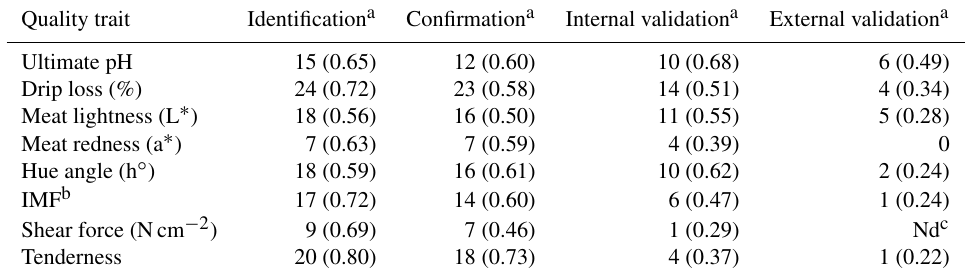
Figure 1. Identification of biomarkers of meat quality by transcriptomic analysis of longissimus muscle: association between gene expression level on muscle 15K microarray and individual meat quality traits (ultimate pH; colour: lightness, redness, hue angle; drip loss; intramuscular fat content; shear force of cooked meat; sensory tenderness; and juiciness). Table 2. Identification, confirmation and validation of biomarkers of pork quality. Significant correlations ( P <0.05) between meat quality traits and the expression level of 40 genes at steps of identification (microarray, n = 50 pigs), confirmation (RT-PCR, n = 50 same pigs as identification step), internal validation ( n = 50 different animals from same experimental design as confirmation step), and external validation (RT-PCR, n = 100 pigs genetically different from previous steps, commercial chain). Adapted from Lebret et al. (2013b). Quality trait Identification a Confirmation a Internal validation a External validation